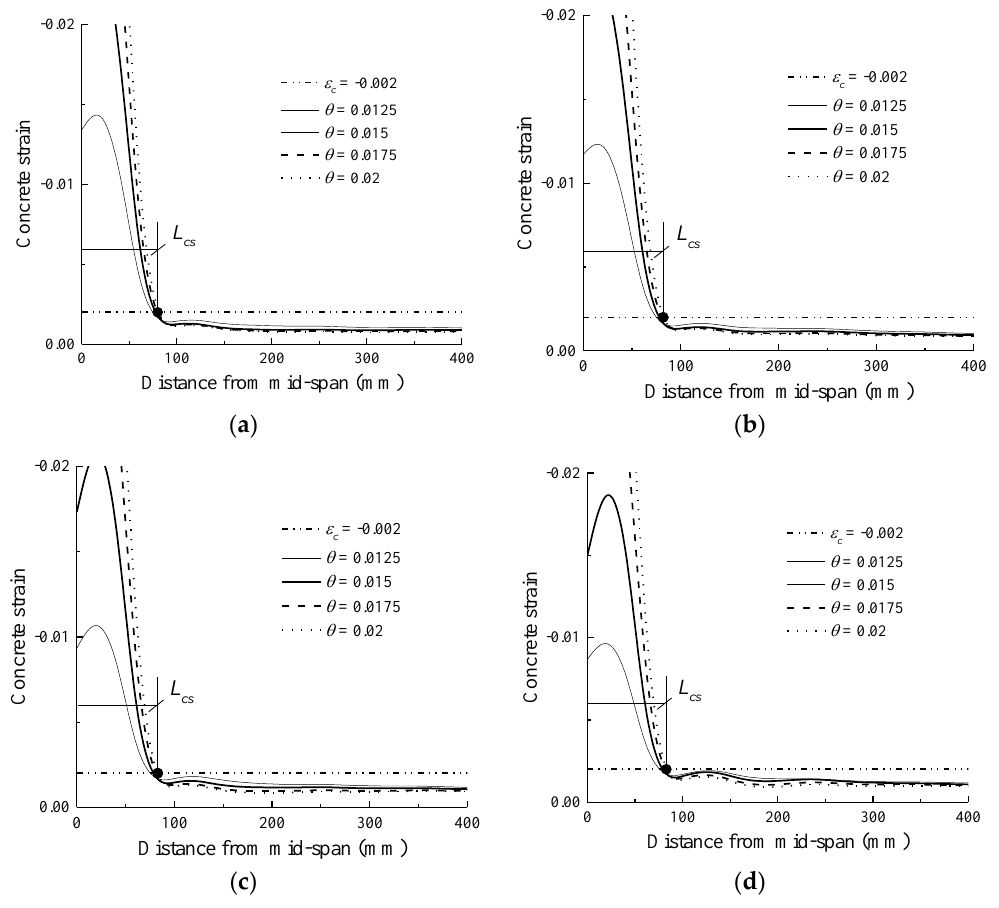
Figure 7. Concrete compressive strain distribution: ( a ) ρ r = 0; ( b ) ρ r = 0.33; ( c ) ρ r = 1; ( d ) ρ r = 3.